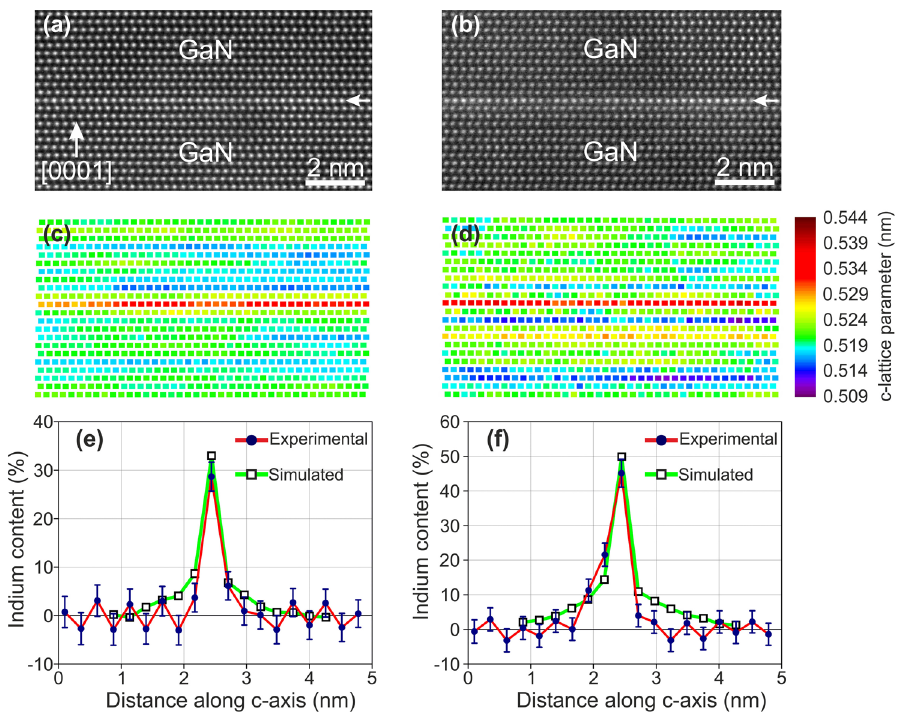
Figure 3. Representative HRSTEM images of QWs with quantitative analysis of composition and strain. ( a,b ) Cross-sectional HAADF-HRSTEM images recorded along [ 1120 ] from samples A1 and A3, respectively. ( c,d ) Corresponding nanoscale maps showing the variation of the c -lattice parameter. ( e,f ) Corresponding composition profiles extracted from the quantification of the Z-contrast. The image-simulated profiles for the indium contents of 33% and 50% are also overlapped in (e,f)